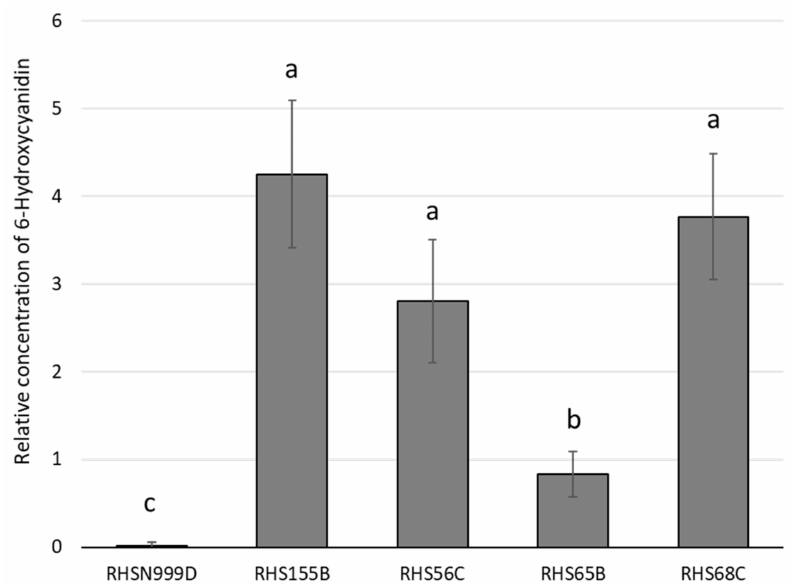
Figure 1. Relative concentration of a putative 6-hydroxycyanidin (eq. malvidin 3-glucoside/FW [g]) observed in the tepals of 5 Alstroemeria pallida accessions. Different letters indicate significant differences in ANOVA ( n = 4) followed by an least significant difference (LSD) test ( p ≤ 0.05, mean ± SE).